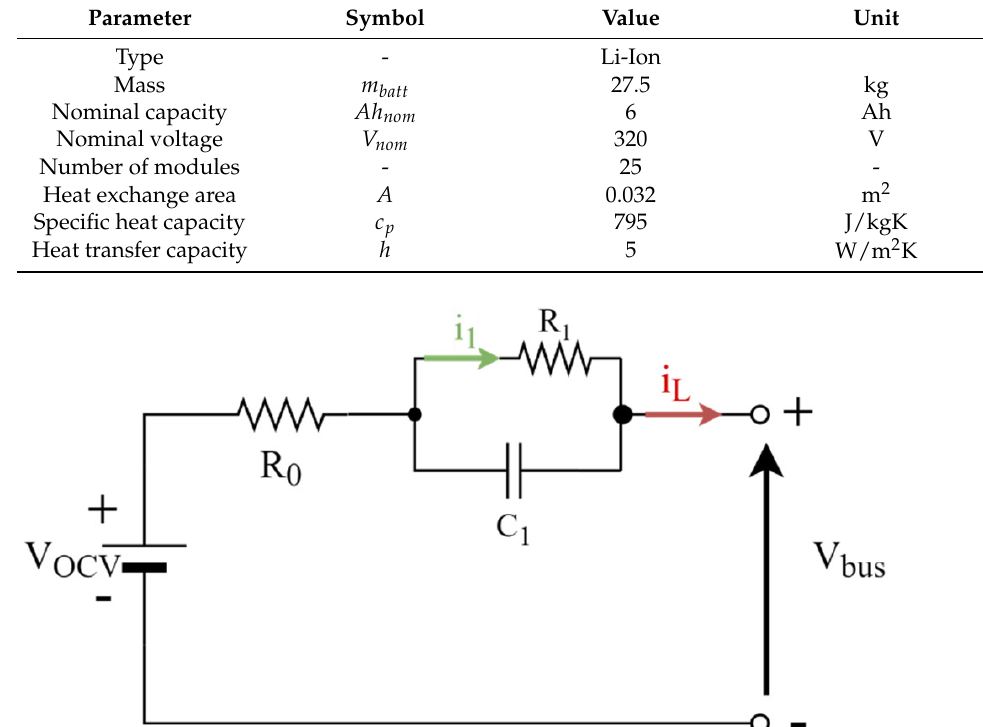
Table 2. Nominal battery parameters.